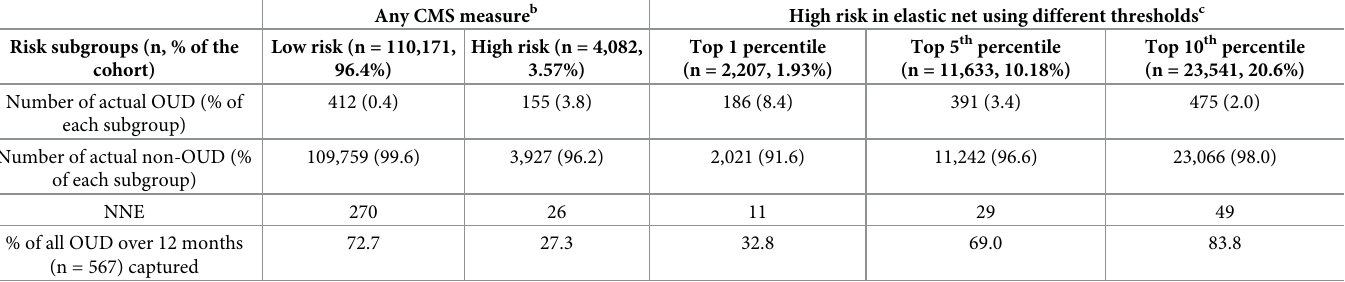
Table 2. Comparison of prediction performance using any of the Centers for Medicaid & Medicaid Services (CMS) high-risk opioid use measures vs. elastic net in the validation sample (n = 114,253) over a 12-month period a . Any CMS measure b High risk in elastic net using different thresholds c Risk subgroups (n, % of the Low risk (n = 110,171, cohort)